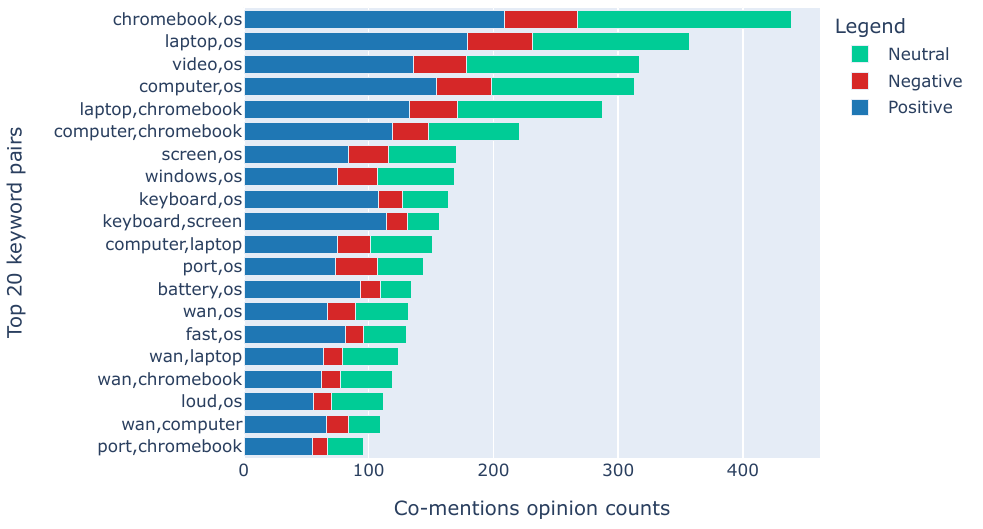
Figure 9. Distribution of opinion interest intensity on top 20 keyword pairs. Table 3. Top 10 positive co-mentioned aspect classes.